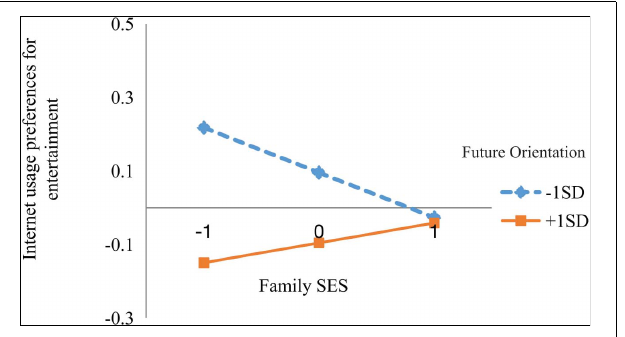
FIGURE 3 | Future orientation as a moderator of the direct relationship between SES and academic